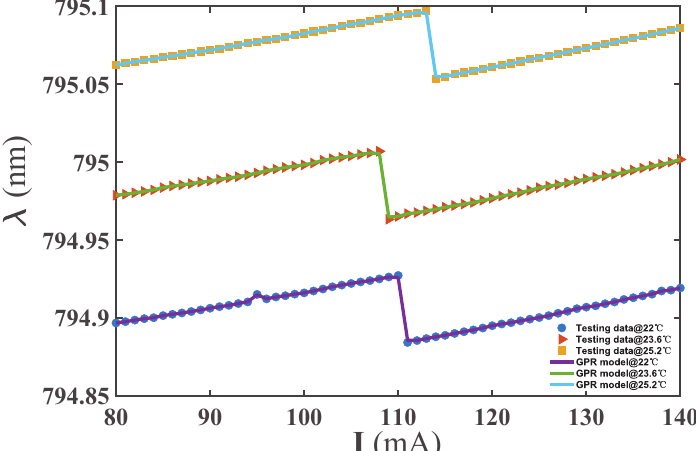
Figure 6. Change in wavelength with current rising at a fixed temperature in the test results for the GPR − λ model.